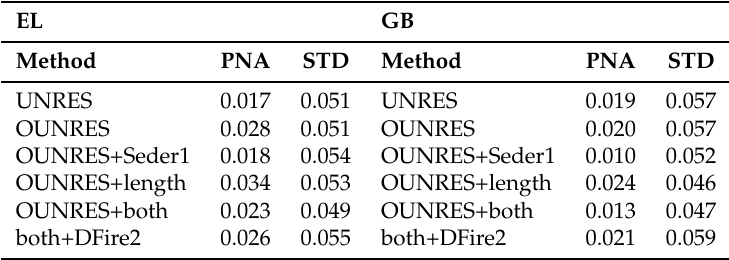
Table 8. Path to Native Accuracy